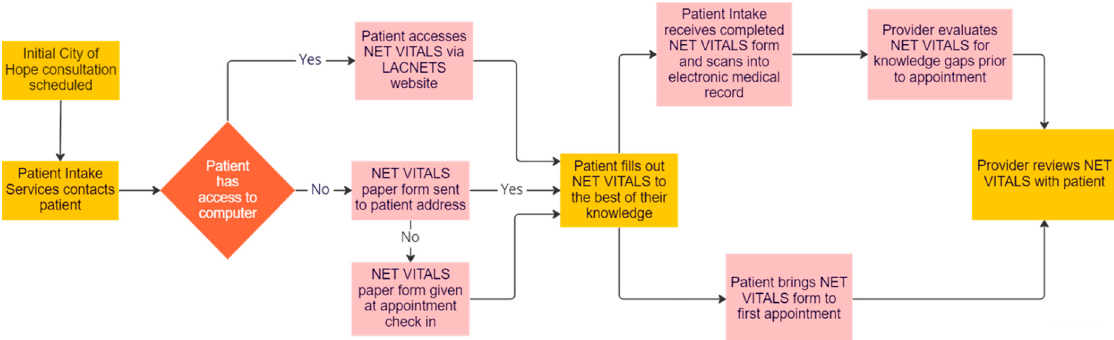
Figure 2. Proposed implementation of NET VITALS.